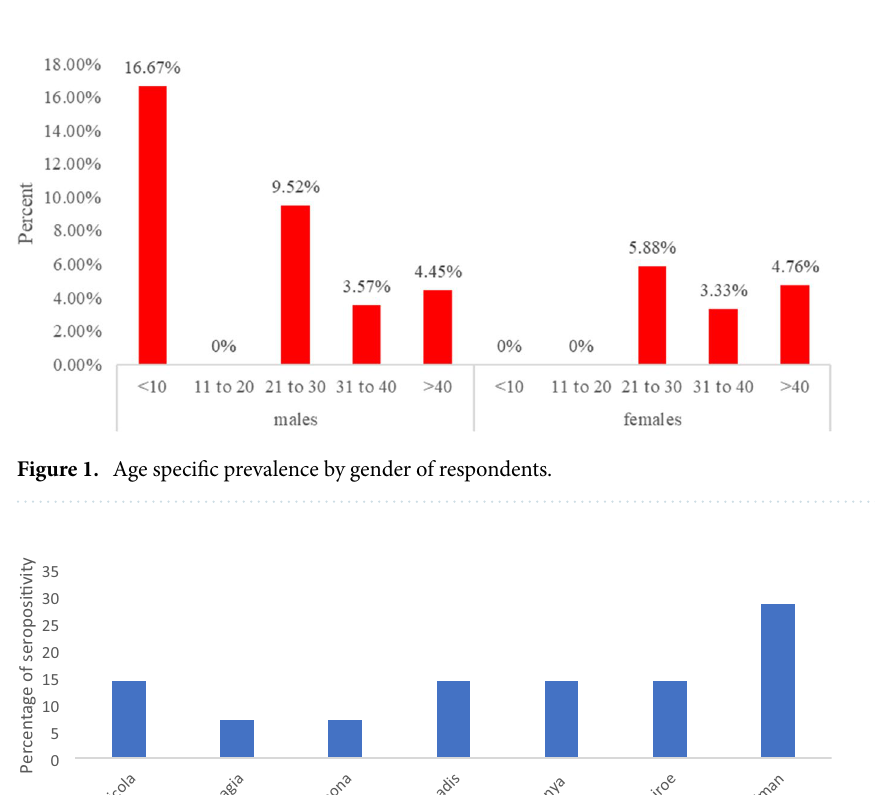
Table 4. Multivariable logistic regression-table. Where CI is confidence interval, OR is the odd ratio, *Significant at a p -value less or equal to 0.05.